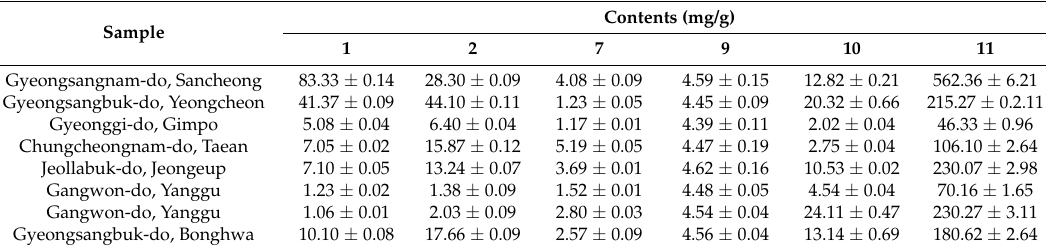
Table 5. Content of compounds 1 , 2 , 7 , 9 , 10 by region in